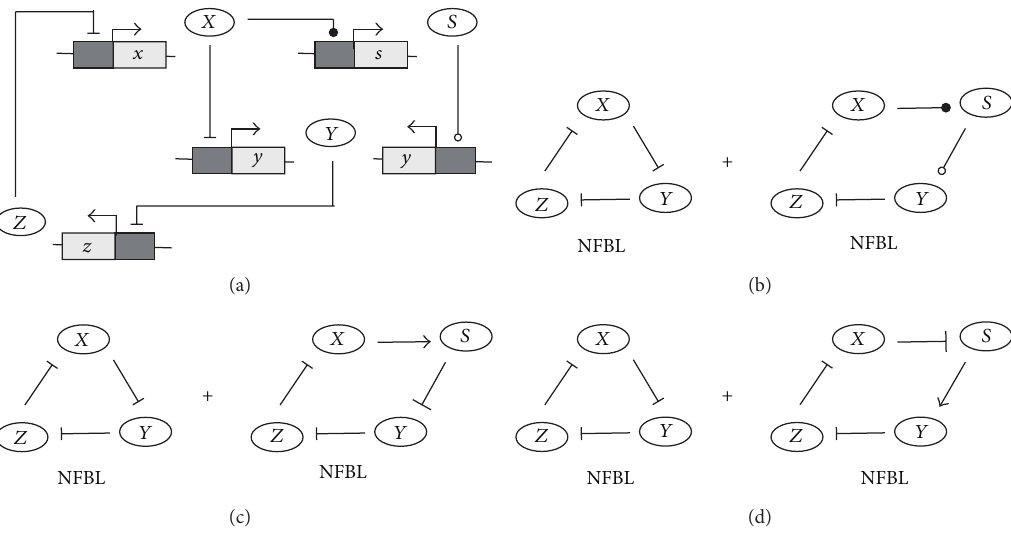
Figure 1: Schematic diagrams of the coupled two negative feedback genetic circuits. Panel (a) is the transcriptional regulation networks for two different coupled negative feedback loops. panel (b) is the simplified and separated schematic diagram of panel (a). In panel (b), the black circle and the white circle are of opposite regulating functions, namely, “activation → + repression ⊣ ” shown in panel (c) or “repression ⊣ + activation → ” shown in panel (d). Arrows denote activation and “ ⊣ ” symbols denote repression. The central negative feedback loop consists of three components ( 𝑋 , 𝑌 , and 𝑍 ); meanwhile, the additional feedback loop consists of components 𝑋 , 𝑆 , 𝑌 , and 𝑍 .